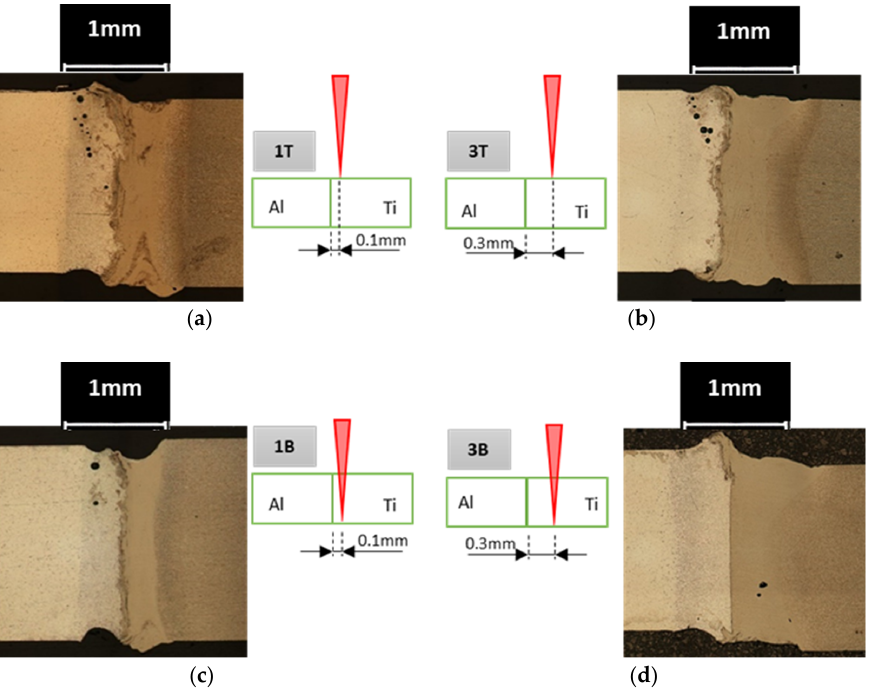
Figure 1. Cross section of the joints 1T ( a ), 3T ( b ), 1B ( c ) and 3B ( d ) coupled with the schemes of the process .